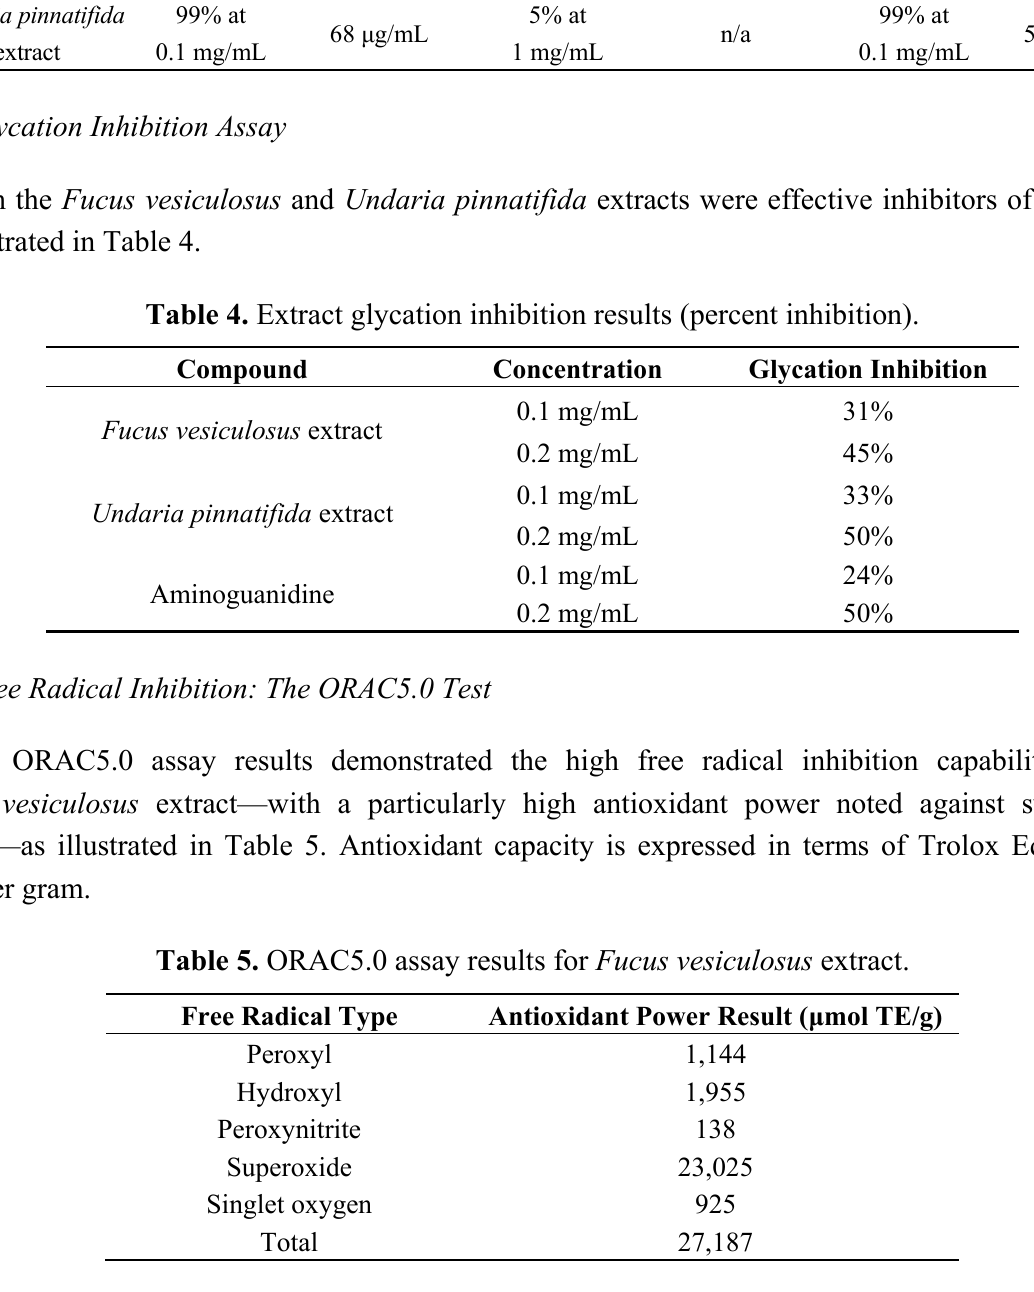
Table 3. Extract elastase, tyrosinase and collagenase inhibition results (percent inhibition). Elastase Extract Inhibition Fucus vesiculosus extract Undaria pinnatifida extract